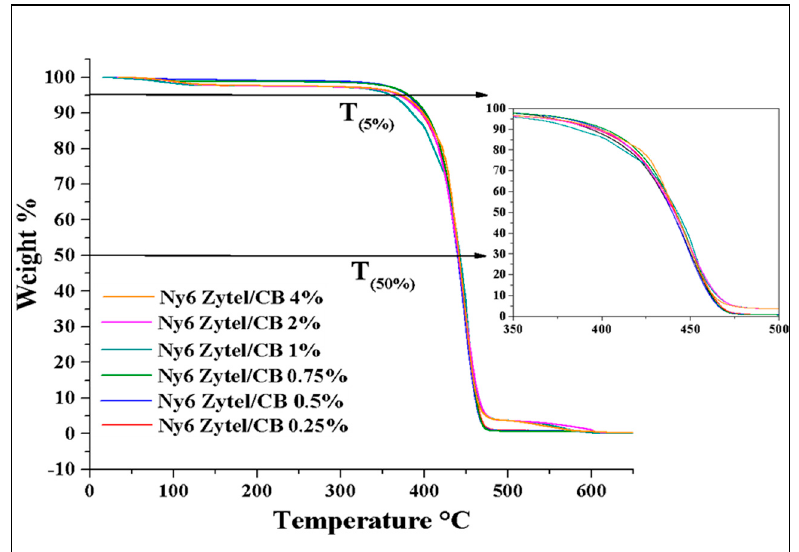
Figure 3. Thermogravimetric analysis of Ny6 Zytel/CB nonwoven fabrics at different concentrations (0.25, 0.5, 0.75 1.0, 2.0, and 4.0%).